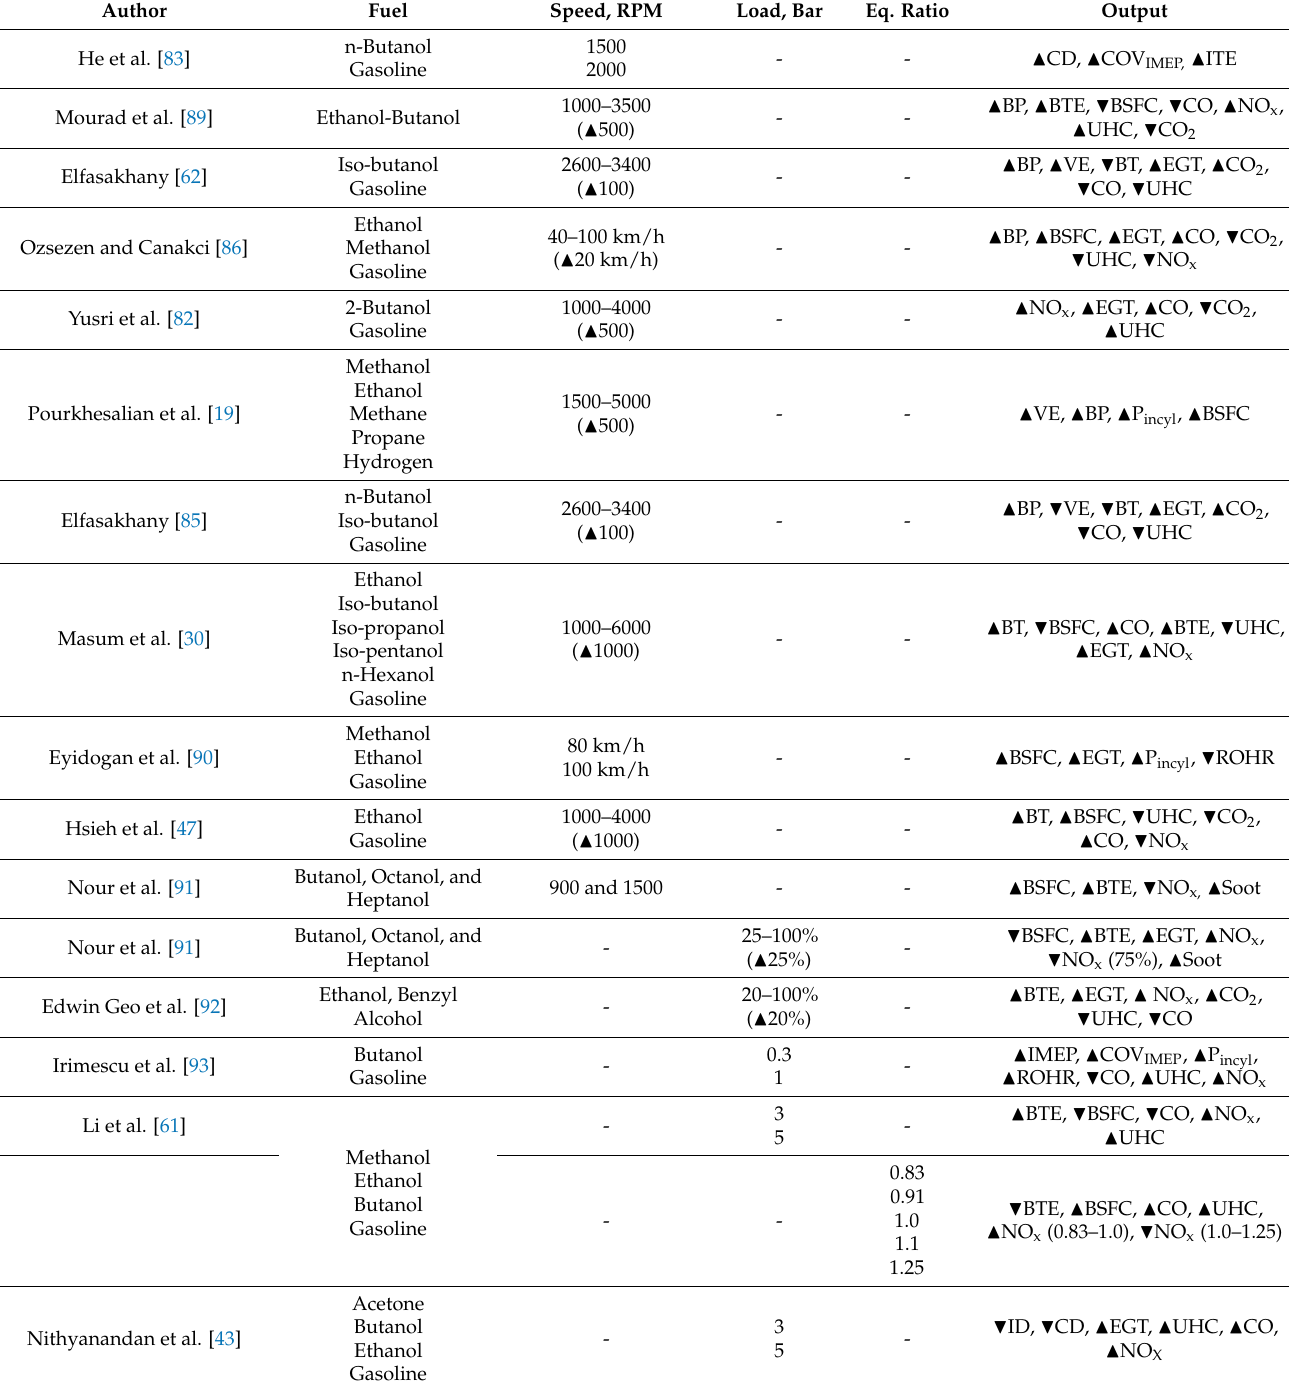
Table 2. Effects of varying engine speeds and loads on engine performances and combustion